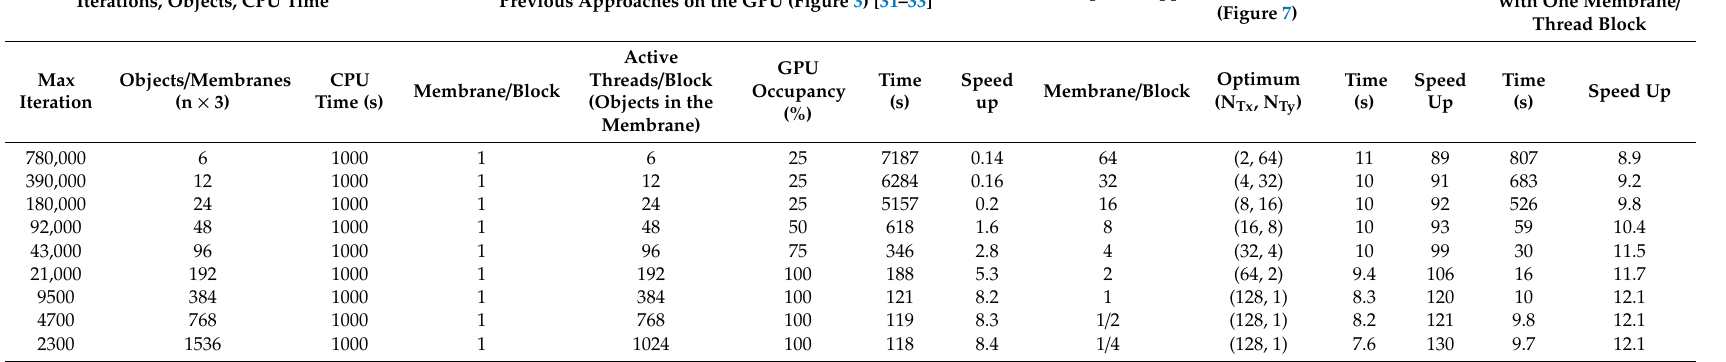
Table 1. Comparing the proposed approaches with decreased communication for 16,382 membranes, di ff erent objects inside each membrane for the system as in Equation (10)